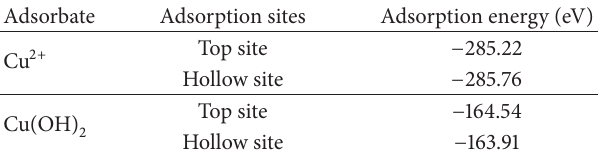
Table 1: Adsorption energies of Cu 2+ and Cu(OH) 2 at different pyrite surface sites.